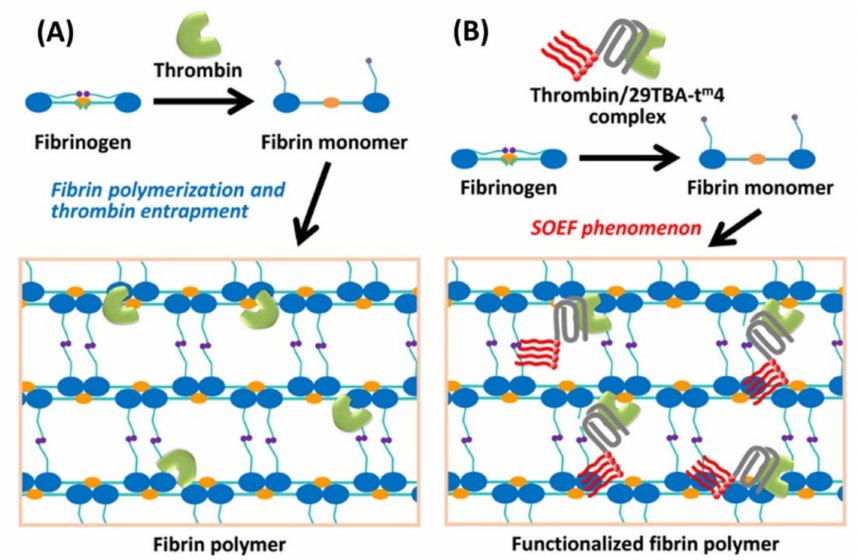
Figure 5. Scheme comparing fibrin formation and the “selective oligonucleotide entrapment in fibrin polymers” (SOEF) phenomenon for the preparation of a functionalized fibrin polymer using a modified thrombin-binding DNA aptamer. Reproduced with permission from [41], Elsevier,